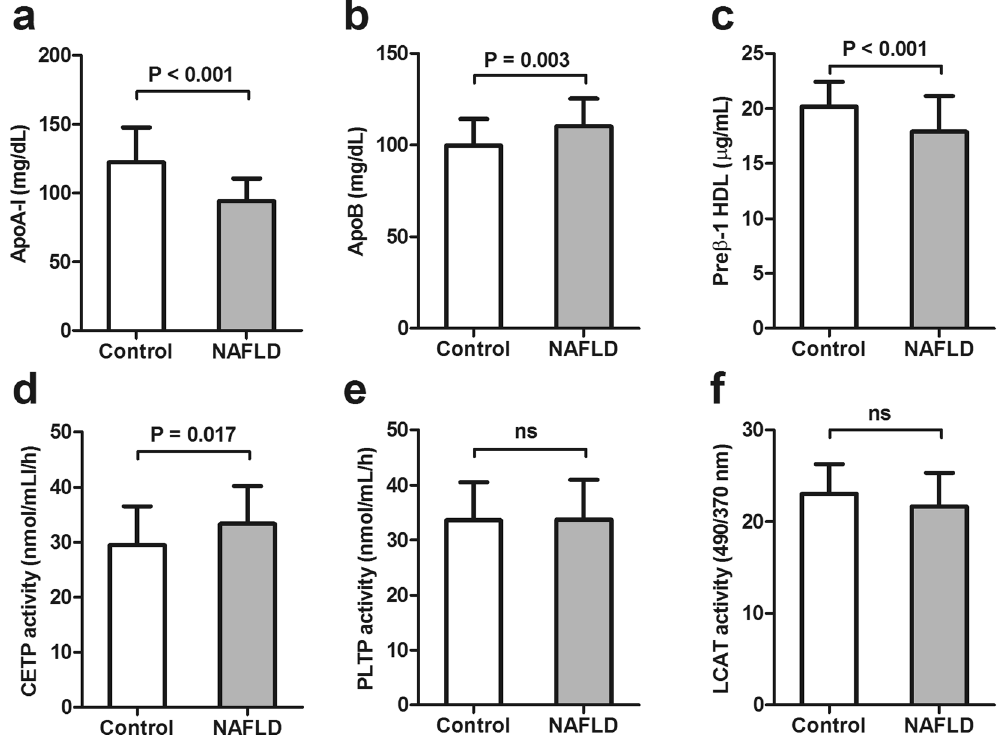
Figure 1. Apolipoproteins levels, enzyme activities. ( a ) Apolipoprotein A-I (ApoA-I) plasma concentration in NAFLD group (94.5 ± 2.2 [mg/dL]) was lower than controls (122.6 ± 4.6 [mg/dL]). ( b ) Plasma apolipoprotein B (Apo B) in NAFLD group (110.18 ± 2.04 [ng/mL]) demonstrated higher concentration compared with controls (99.75 ± 2.63 [mg/dL]). ( c ) Prebeta1-HDL (Pre β 1-HDL) level in NAFLD (17.89 ± 0.44 [ µ g/mL]) showed significant decrease compared with controls (20.17 ± 0.41 [ µ g/mL]). ( d ) Activity of Cholesterol Ester Transferase Protein (CETP) in NAFLD (33.34 ± 0.93 [nmol/mL/h]) demonstrated significant increase compared with controls (29.50 ± 1.29 [nmol/mL/h]). ( e ) Activity of Plasma Lipid Transfer Protein (PLTP) in controls was an average of 33.55 ± 1.26 nmol/mL/h, in NAFLD was 33.71 ± 0.98 nmol/mL/h that showed no significant difference. ( f ) Activity of Lecithin Cholesterol Acyl Transferase (LCAT) showed no significant difference between controls (23.07 ± 0.59 [490/370 nm]) and NAFLD group (21.69 ± 0.49 [490/370 nm]). Data are given with mean ±